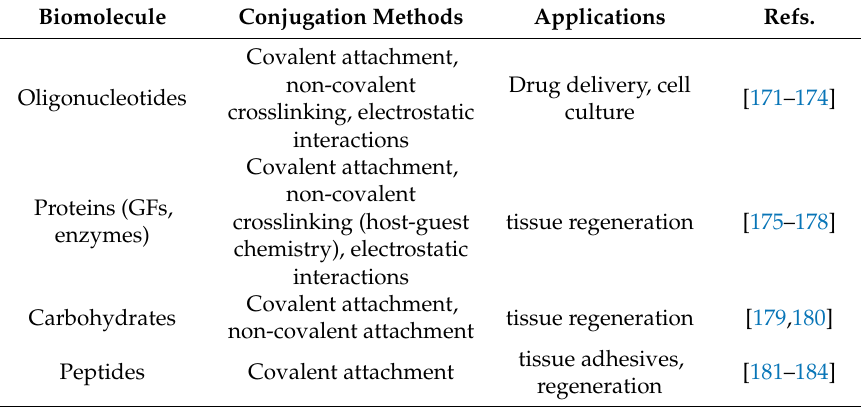
Table 2. Summary of biomolecules entrapped within the matrix of